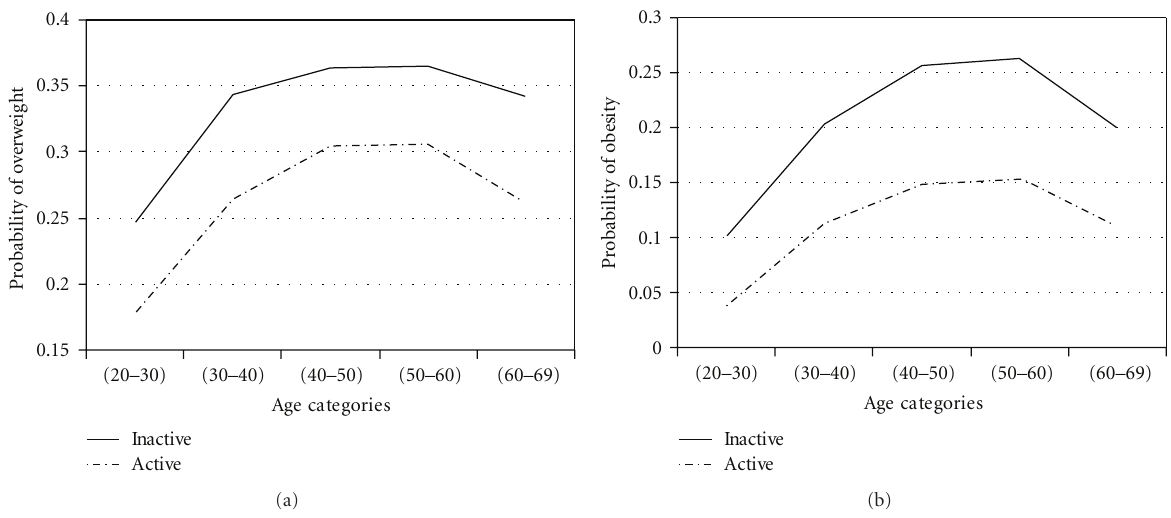
Figure 4: Probabilities of overweight and obesity across age groups for workforce